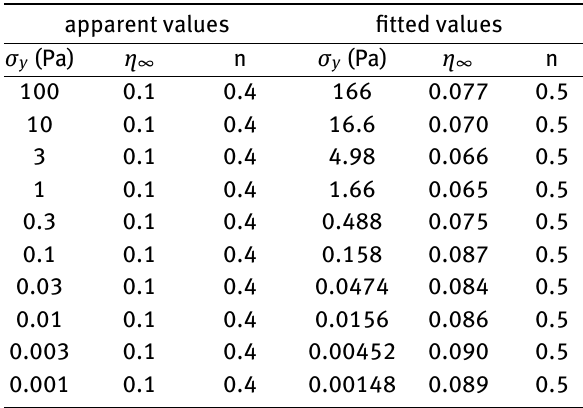
Table 4: Apparent parameters used to generate curves on Figure 2 and the best-fit parameters calculated from the simulated curves to produce the “true” curves on that